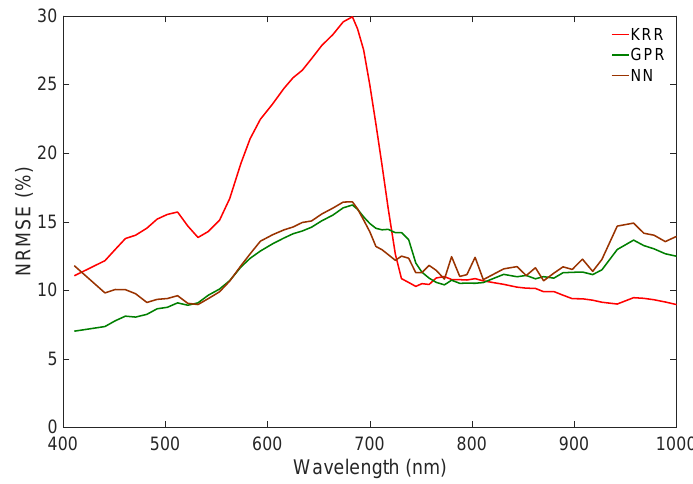
Figure 5. Wavelength-dependent NRMSE (%) comparison of scenes as generated by the three tested emulators (KRR, GPR, NN) against a reference CHRIS scene.